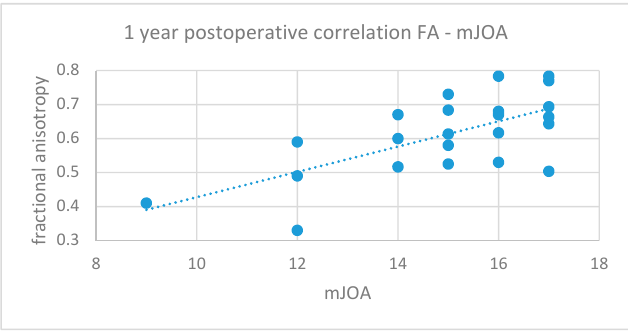
Figure 6. Positive correlation between preoperative FA and mJOA at 1 year ( p = 0.004, r = 0.66).